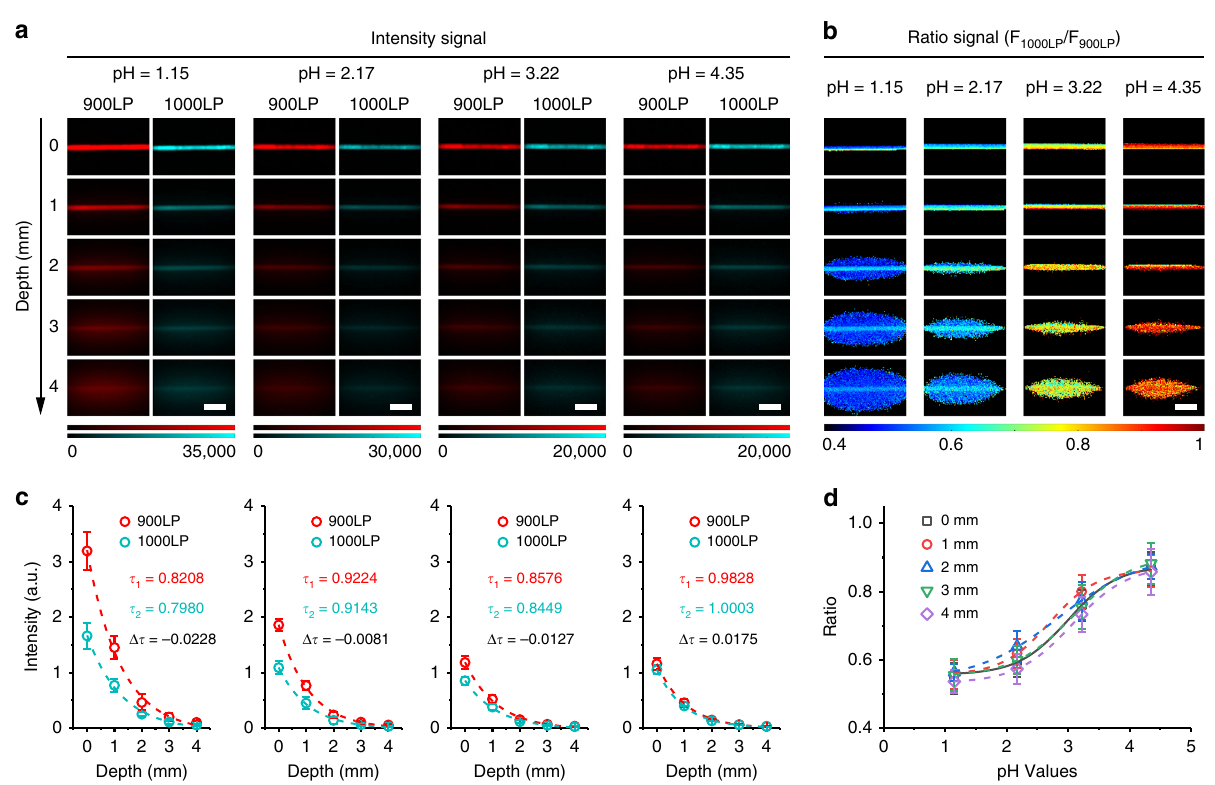
Fig. 6 Ratiometric fl uorescence imaging of pH with BTC1070 in mimic tissue. Fluorescence images a and corresponding ratiometric fl uorescence images b of capillary tubes fi lled with BTC1070 micelle solution of different pH with varying depth from 0 to 4 mm. Excitation wavelength: 808 nm. Emitted signals were collected through passing 900LP (F 900LP , red channel) and 1000LP (F 1000LP , cyan channel) fi lters, respectively. F 1000LP /F 900LP denotes the ratio signals. The detailed imaging parameters for each image are listed in Supplementary Table 1. Scale bar, 2.5 mm. c Measured intensity of capillaries as a function of depth (0 – 4 mm) in 1% Intralipid, corresponding to the fl uorescence images of each pH value. τ 1 and τ 2 denote the signal attenuation coef fi cients of red and cyan channels, respectively, derived from the single-exponential fi tting curves. The little differences between τ 1 and τ 2 ( Δ τ = τ 1 – τ 2 ) are responsible for the reliable ratio signals with increased depth (Supplementary Note 2, Supplementary Figure 23). d Plots of measured ratio changes as a function of pH with varying depth. Curve fi tting ( r 2 > 0.98) is based on Boltzmann function in origin software (Supplementary Equation 2), generating the calibration functions at different depths (Supplementary Note 3). Data point with its error bar stands for mean ± s.d. derived from n = 3 replicated measurements of every pixel in the capillaries. Source data are provided as a Source Data fi